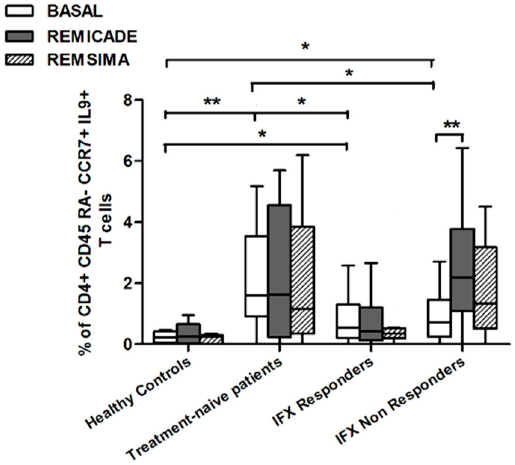
Figure 4. Percentages of CD45RA − , CCR7 + , IL-9 + CD4 + (central memory) T cells at baseline and after exposure to branded and biosimilar infliximab. * p < 0.05, ** p <0.01.